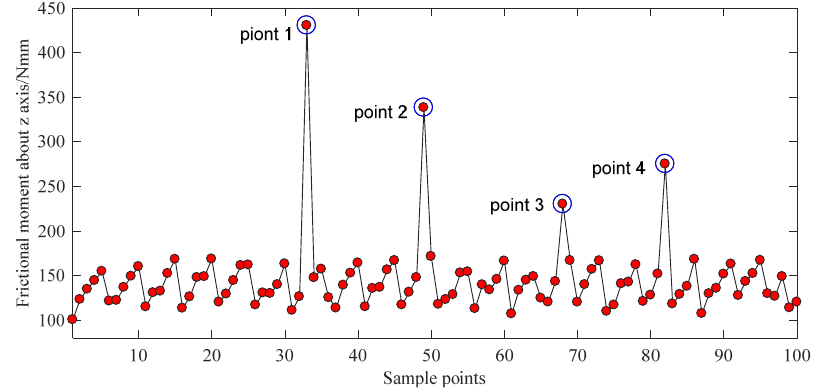
Figure 6. Bowl-shaped tiles’ friction torques of 100 sample points.